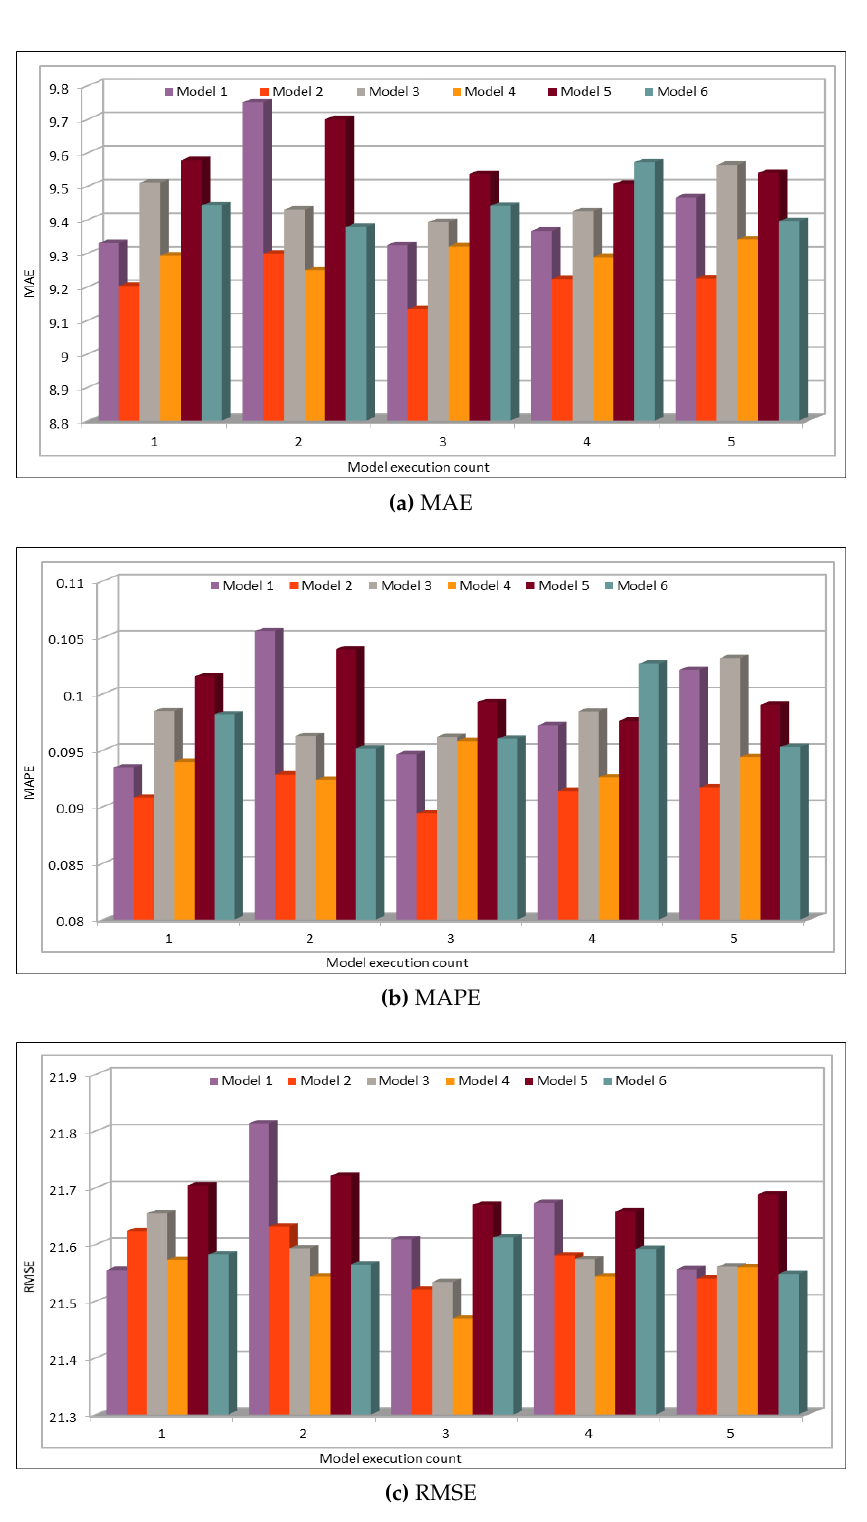
Figure 16. Traffic occupancy: MAE, MAPE, and RMSE evaluation